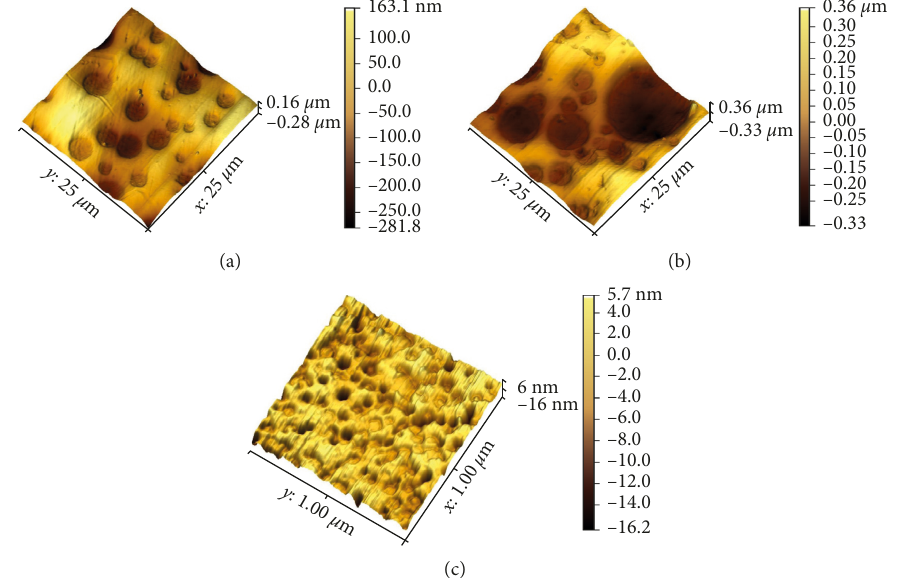
Figure 7: Images obtained by AFM. (a) Silica-zirconia nanoclusters, (b) silica nanoclusters, and (c) nonaggregated silica